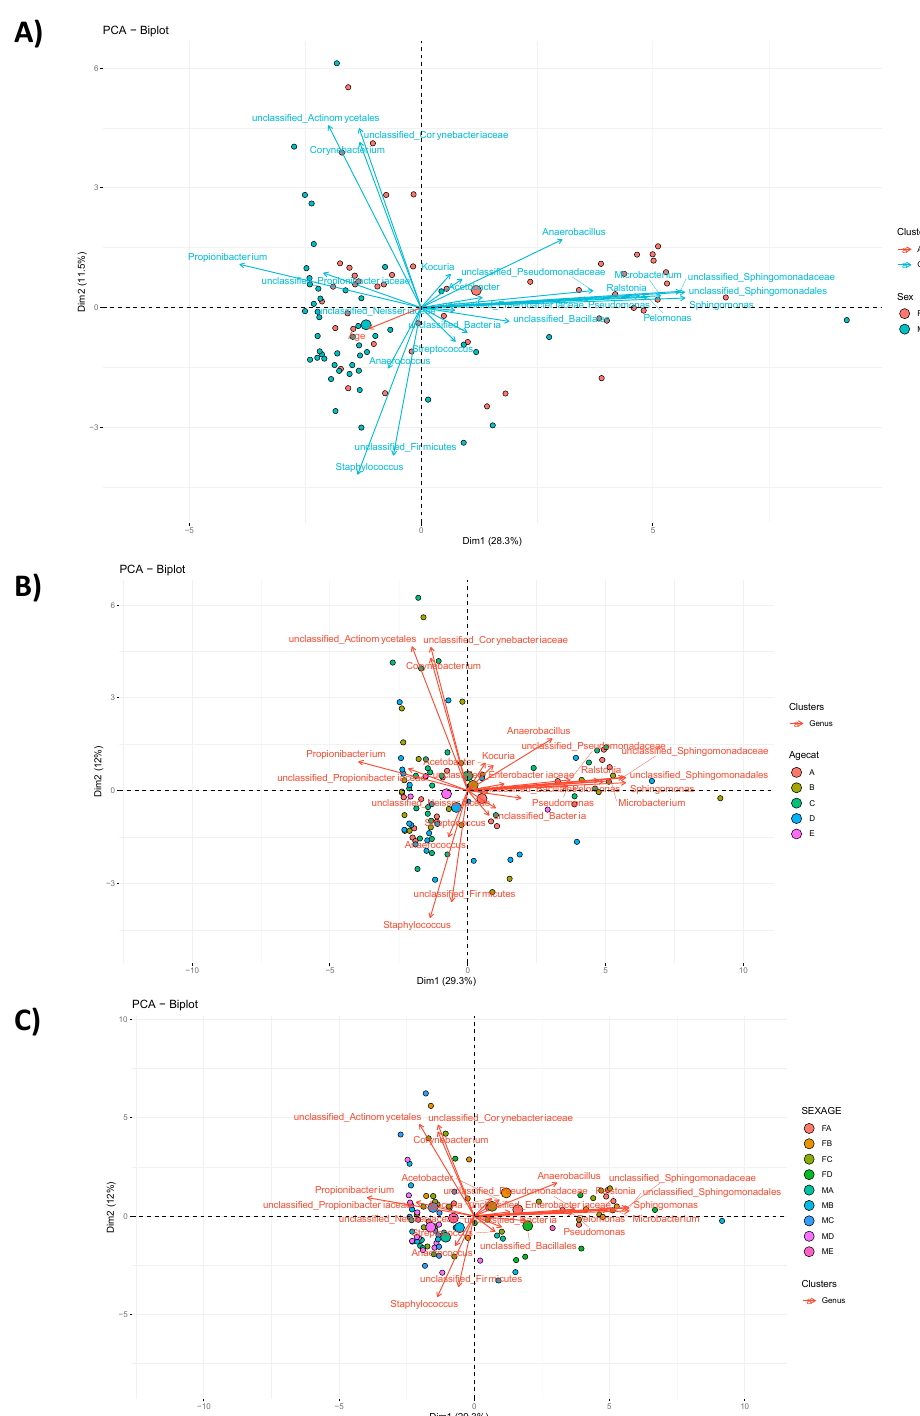
Figure 2. PCA analysis at Genus level based on the following: ( A ) Sex (39.8% of variability explained by dimensions 1 and 2); ( B ) Age categories (A: 25–35 years old, B: 36–45, C: 46–55, D: 56–65, E: 66–70; 41.3% of variability explained by dimensions 1 and 2); ( C ) Sex + Age categories, 41.3% of variability explained by dimensions 1 and 2. The largest ball represents the mean of the samples, while the small dot indicates the single sample.